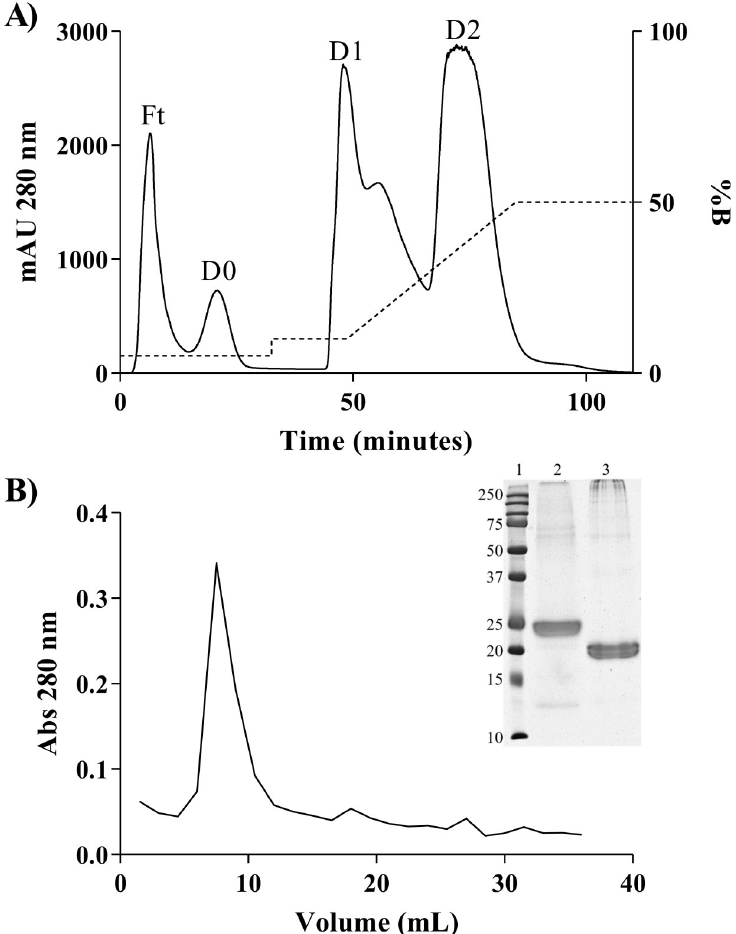
Fig 1. The purification process of the Boa γ PLI. A) Fractionation of B . constrictor serum. HiTrap DEAE column ion exchange chromatography (5 mL), flow 1 mL / min. Five ml of serum diluted in buffer A were applied to the chromatography. Three resulting fractions were evidenced: D0, D1, and D2. B) Elution of D2 fraction retained on CNBr-activated Sepharose resin-coupled crotoxin affinity chromatography (GE Healthcare). Elution was performed with 0.1 M glycine, pH 2.7, pH neutralized with the addition of 1 M Tris, pH 8.8. Elution was manually dosed at 280 nm. Insert: SDS-Page 12% of the Boa γ PLI in reducing (2) and non-reducing conditions (3). 1) Molecular mass marker Dual Color Precision Plus, Biorad.